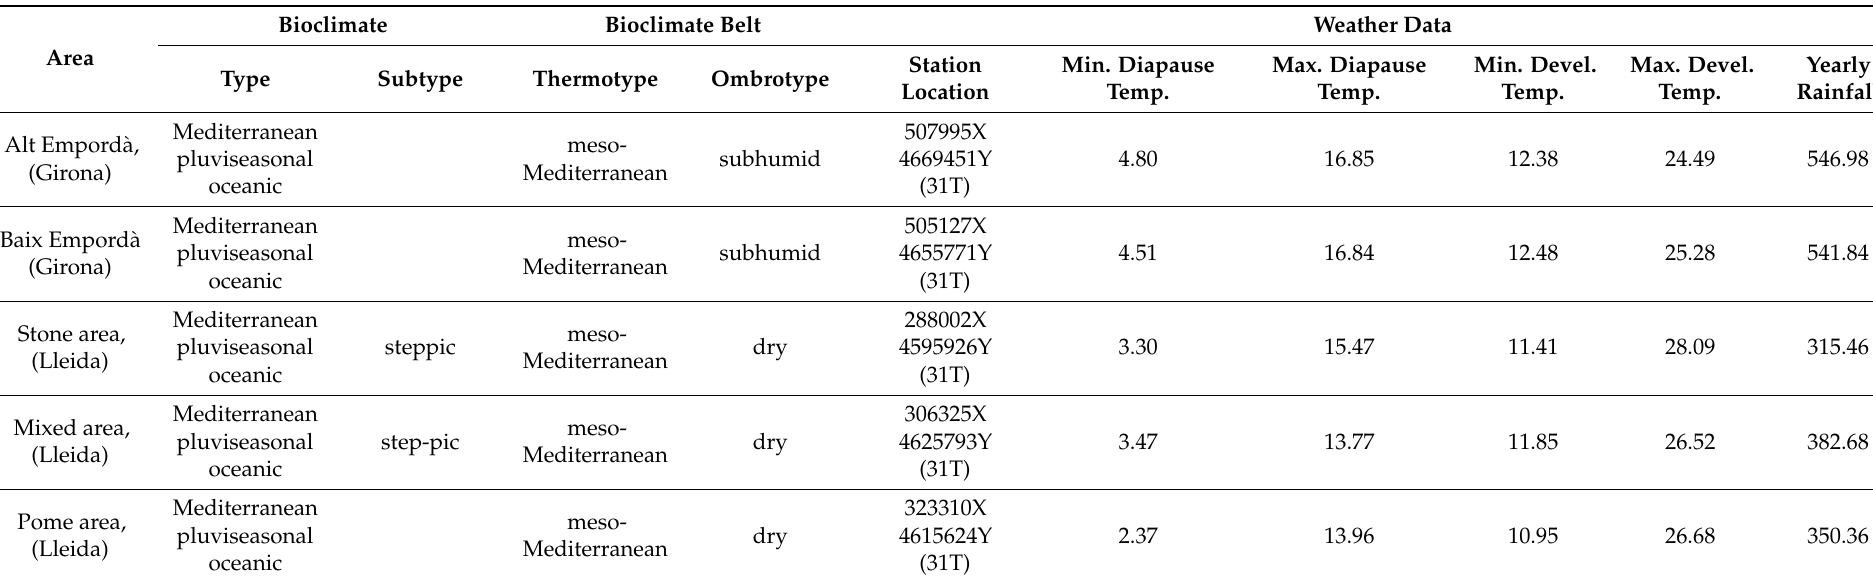
Table 1. Bioclimatic (based on the Worldwide Bioclimatic Classification System) and meteorological data for the five studied areas. Meteorological data were obtained from the official weather stations associated with each area from 2015–2019. The UTM (Universal Transverse Mercator) coordinates for each weather station are indicated. Minimum and maximum temperatures for the period of diapause of G. molesta were calculated from October to February, and equivalent temperatures for the developing period from March to